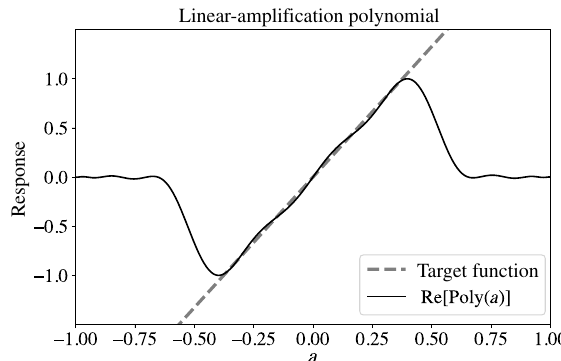
FIG. 26. The response function for the linear amplification polynomial with (cid:24) = 0.25 and d =